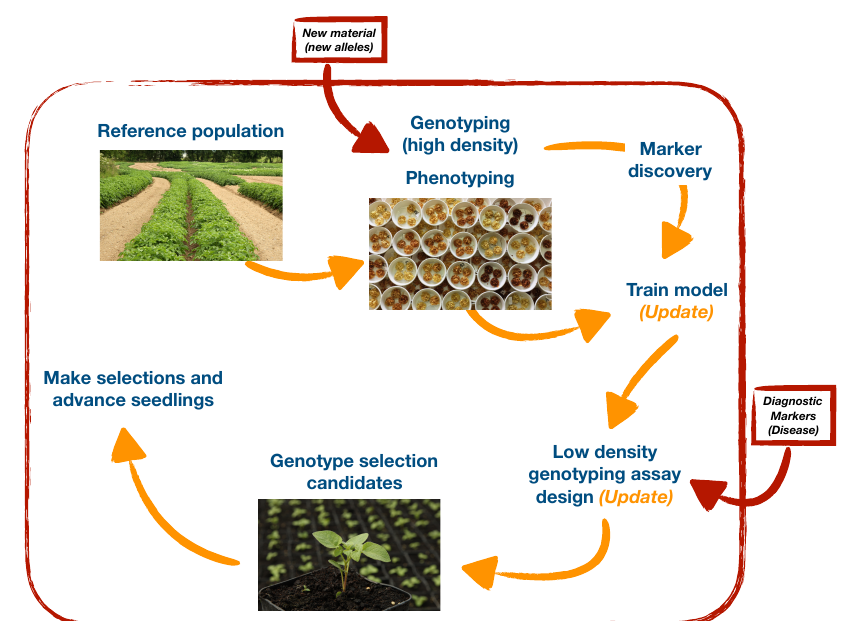
Figure 5. Pathway to implementation of marker-assisted selection in potato breeding. An initial reference population representing the breeding material is both genotyped and phenotyped for target traits. These data can be used to identify markers linked to traits and develop prediction